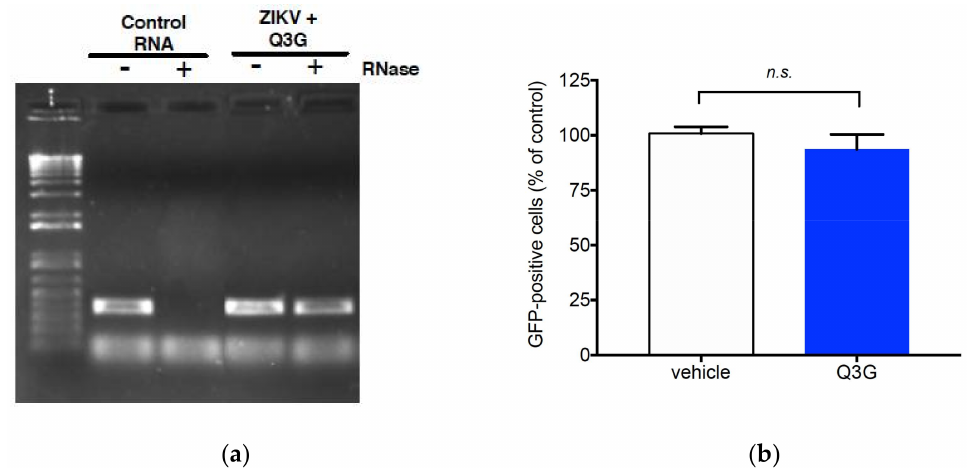
Figure 3. Effect of Q3G on ZIKV infectivity. In ( a ), RNase A protection assay on ZIKV. MR766 MC was incubated with 100 µ M Q3G or mock-treated in presence of RNase A for 1 h at 37 ◦ C. Viral RNA was extracted and amplified by RT-PCR with ZIKV.E primers. Viral RNA extracted from ZIKV and treated with RNase A or vehicle served as controls. Results from a representative experiment ( n = 3 repeats) are shown. In ( b ), Viral inactivation assay. ZIKV GFP was incubated with 100 µ M Q3G or mock-treated at 37 ◦ C for 1 h and the mixture was assessed for viral infectivity on A549 cells at MOI of 0.5 (2 µ M Q3G final concentration). At 24 h p.i., the percentage of GFP-positive cells was determined by FACS analysis. Data represent the means ± SD of four independent experiments performed in